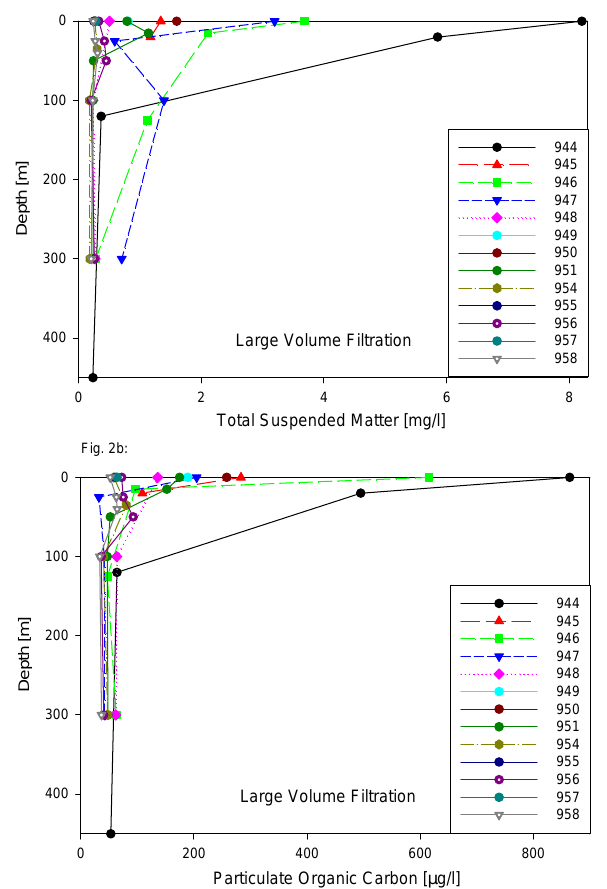
Fig. 2. Total suspended matter concentrations (a) and particulate or- ganic carbon concentrations (b) in vertical profiles from the Arabian Sea. Station numbers are indicated in Fig. 1.